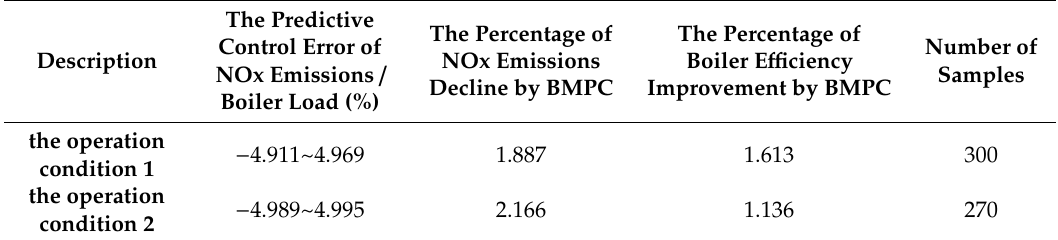
Figure 10. The results obtained with the model predictive control under operating condition 2.